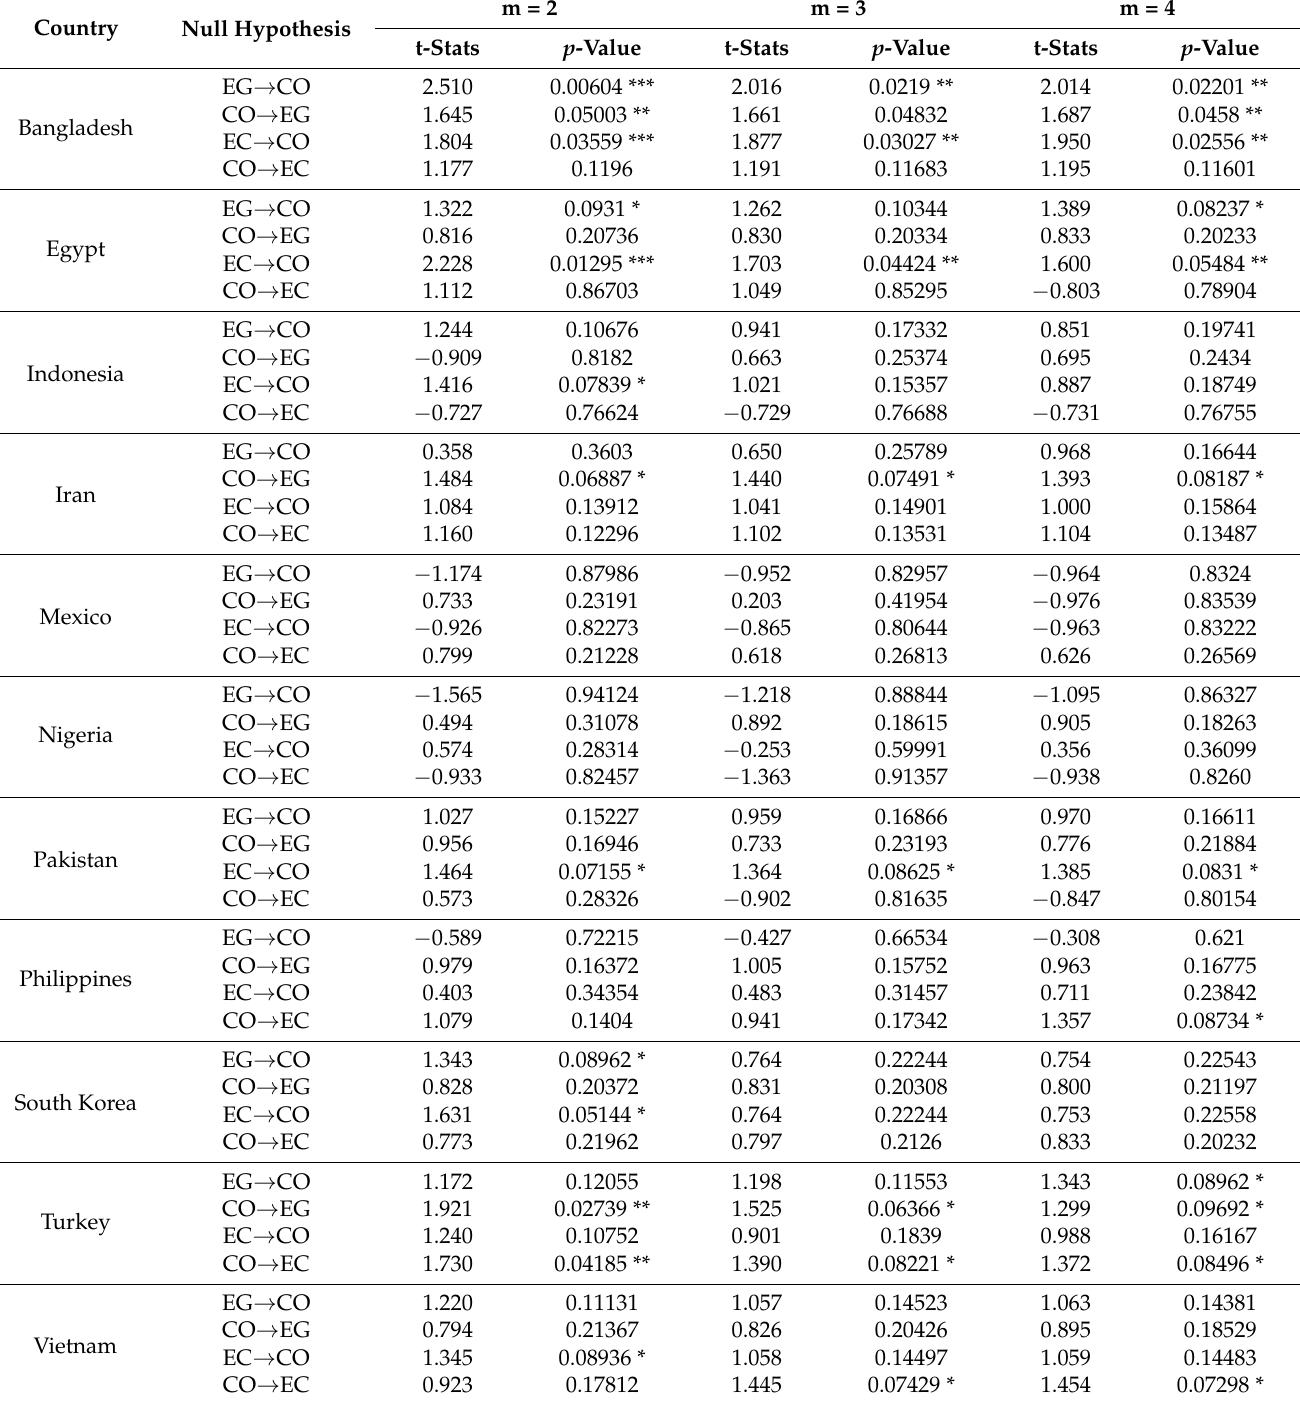
Table 11. Diks and Pachenko asymmetric causality